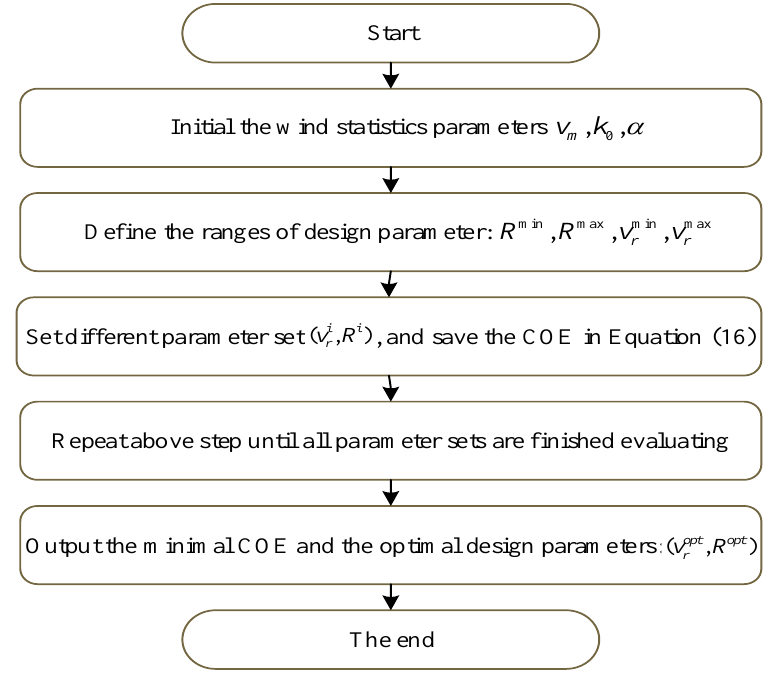
Figure 2. Flow chart of the proposed cost of energy (COE) minimization approach.